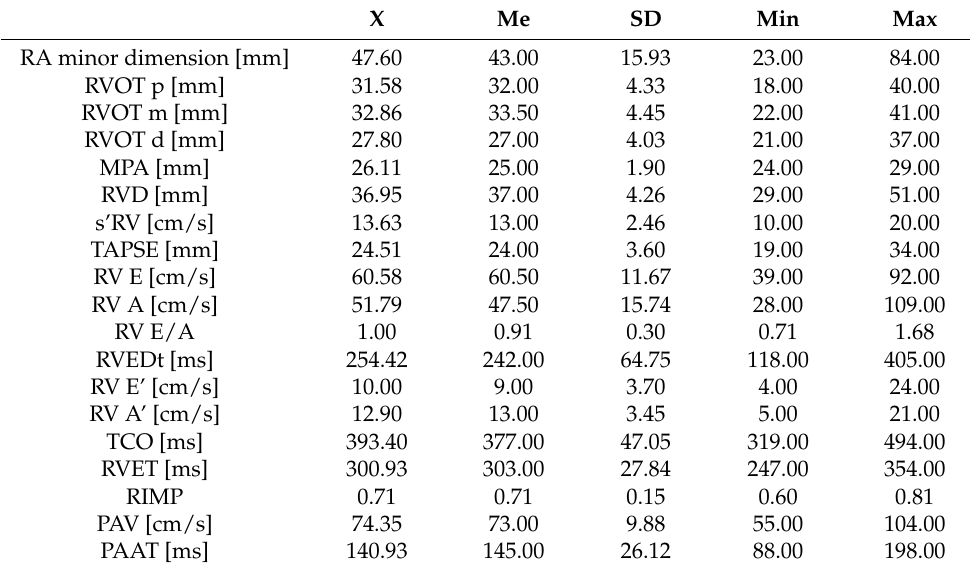
RAA, right atrial area; RA, right atrial; RVOT p, proximal right ventricular outflow diameter; RVOT m, mid right ventricular outflow diameter; RVOT d, distal right ventricular outflow diameter; MPA, main pulmonary artery diameter; RVD, basal right ventricle diameter; s’RV, peak systolic velocity of tricuspid annulus by pulsed wave Tissue Doppler Imaging; TAPSE, tricuspid annular plane systolic excursion; RV E, early peak transtricuspid diastolic flow; RV A, late peak transtricuspidal diastolic flow; RV E/A, ratio of early to late peak transtricuspid diastolic flow; RVEDt, deceleration time of early peak transtricuspid diastolic flow; RV E’, early peak diastolic velocity of tricuspid annulus by pulsed wave Tissue Doppler Imaging; RV A’, late peak diastolic velocity of tricuspid annulus by pulsed wave Tissue Doppler Imaging; TCO, tricuspid valve closure opening time; RVET,